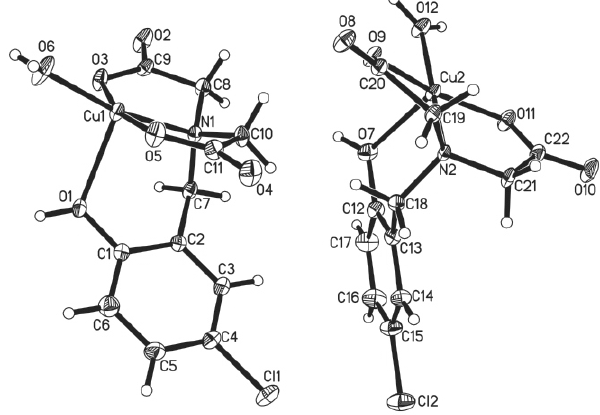
ranges. The copper ion is penta-coordinated. Four vertices come from the ligand, and one from the H